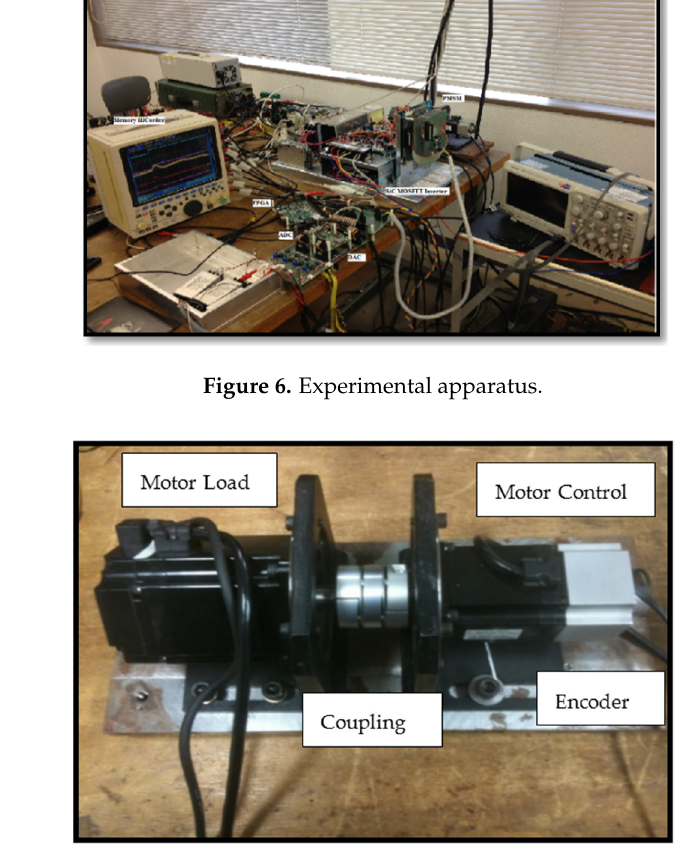
Figure 7. Permanent magnet synchronous motor.